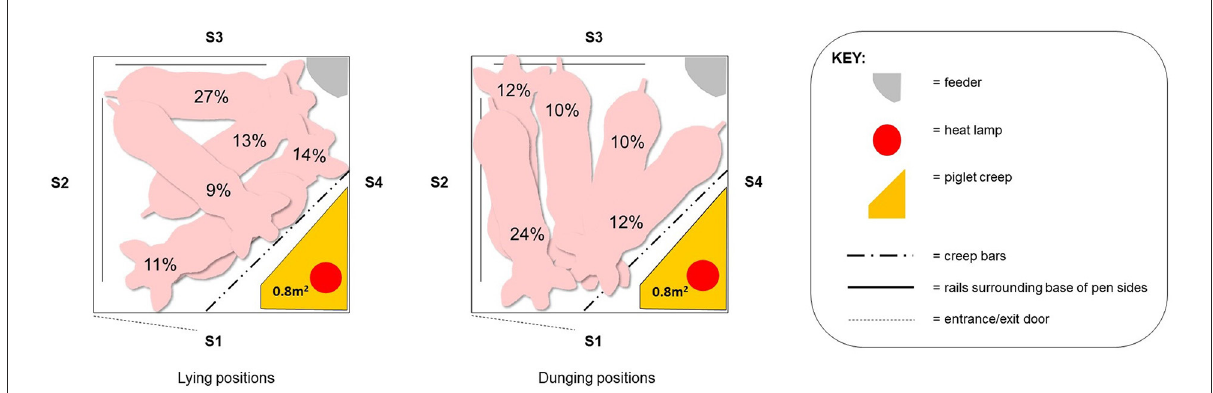
FIGURE5 The five preferred lying positions (left) and dunging positions (right) in a square pen (2.4 × 2.4m) when the sow was loose [adapted from Moustsen et al. (51)]. S1: Pen side at inspection aisle; S2: Pen side opposite piglet creep; S3: Pen side opposite inspection aisle; S4: Pen side/furniture in front of piglet